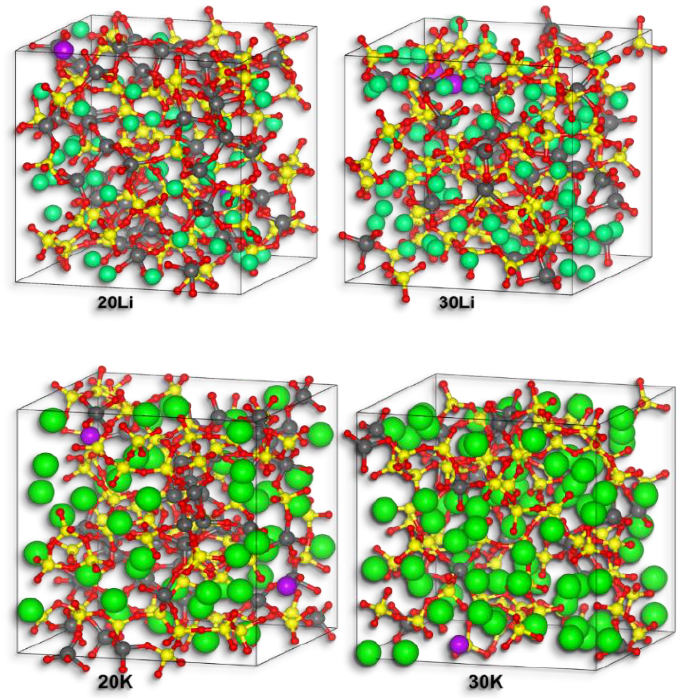
Figure 1. Equilibrium atomic configurations obtained for the four different alkali aluminosilicate glass systems. Si atoms: yellow, Al: grey, O: red, network modifier atoms (Li, K): green, Gd: purple.